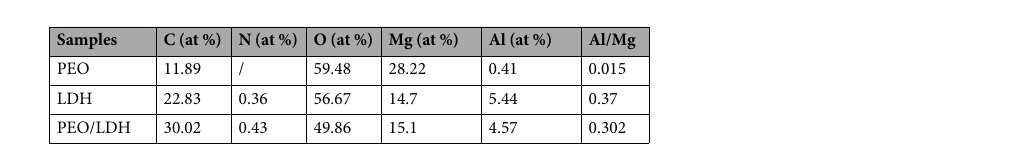
Table 1. Surface elemental composition of coated samples measured by